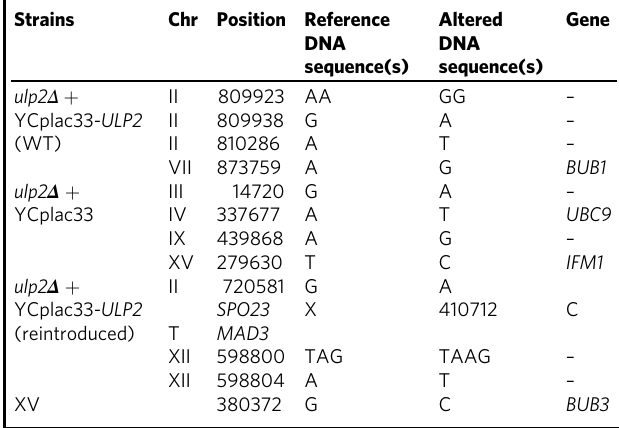
Table 1 Mutations in the original ulp2 Δ strains passaged